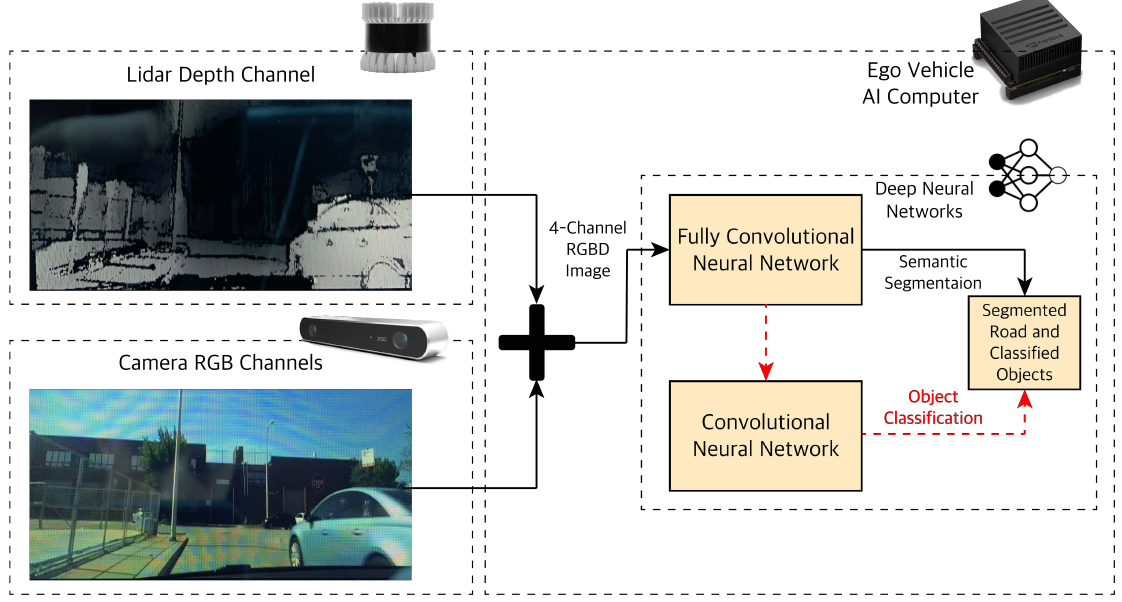
Figure 7. Early fusion of LiDAR depth image and camera image as an input to a DNN